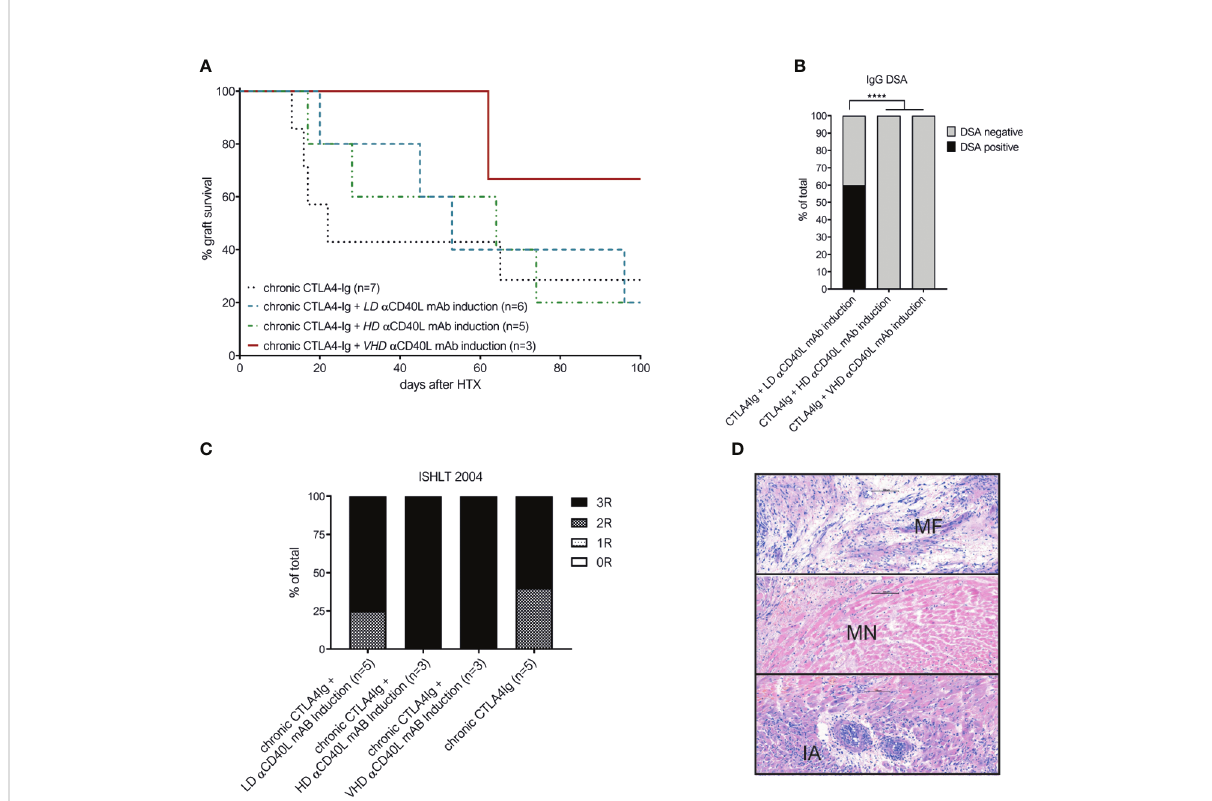
FIGURE 2 Combination of perioperative a CD40L mAb induction with chronic CTLA4-Ig administration does not signi fi cantly improve long-term outcome despite abrogation of DSA formation. (A) Addition of low-dose a CD40L mAb (n=6, turqouise interrupted line), high-dose a CD40L mAb (n=5, green line) or very high-dose a CD40L mAb (n=3, dark red dotted line) to chronic CTLA4-Ig therapy did not prolong heart allograft survival signi fi cantly compared to chronic CTLA4-Ig monotherpy (n=7; black dotted line). (B) Percentage of mice with detectable donor speci fi c IgG antibodies (DSA) at the time of rejection or end of long-term follow up. (C) ISHLT-2004 scoring in histological slides of allografts harvested at rejection of end of follow-up. (D) Representative histological features of chronic allograft damage evident in long term surviving cardiac allografts: myocardial fi brosis (MF), miocardial necrosis (MN) and intimal arteritis (IA). **** indicates